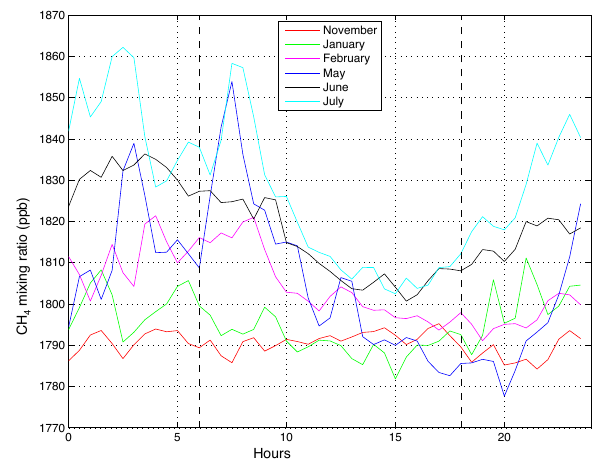
Fig. 7. Monthly averaged diurnal cycles of CH 4 mixing ratios mea- sured with the FMA at the top of the tower K34 during six months. Vertical dashed lines indicate the time of sunrise and sunset, respec-